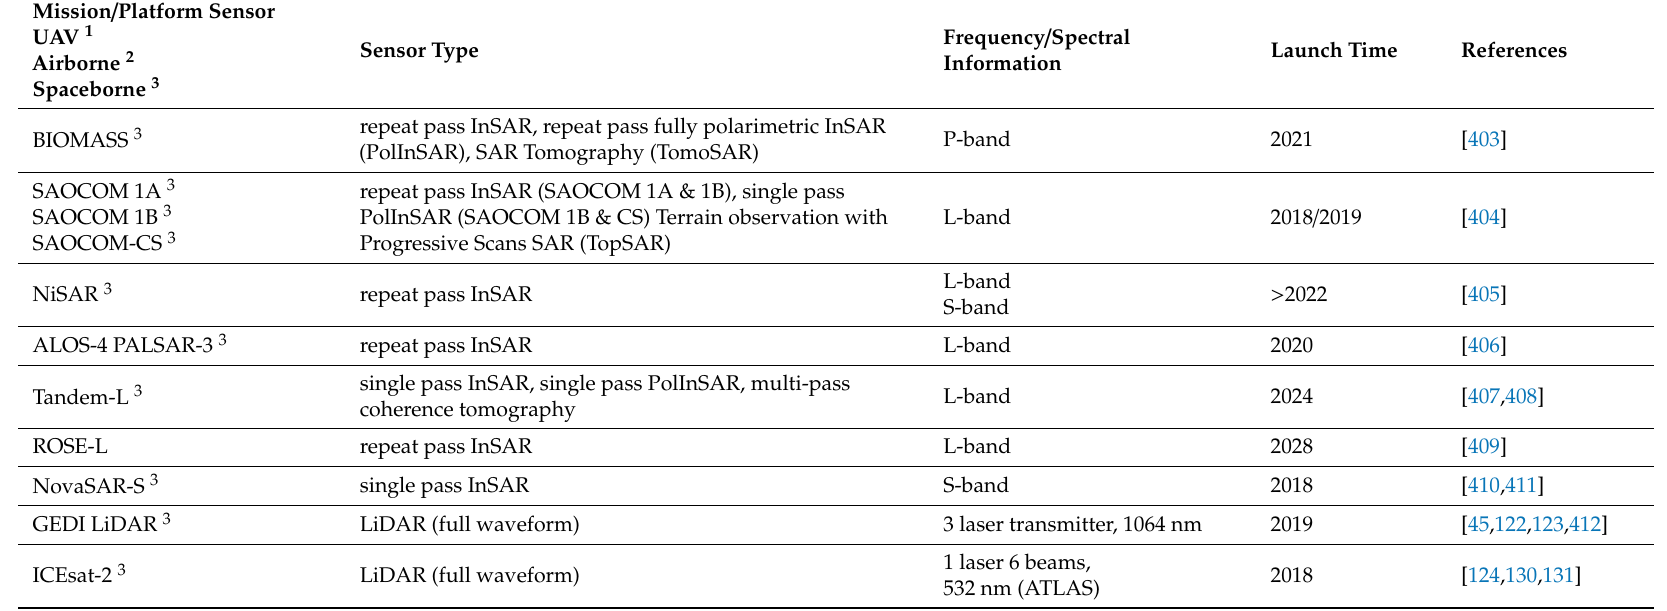
Table 6. Important current and future RS missions and sensors to derive the status and changes of terrain and